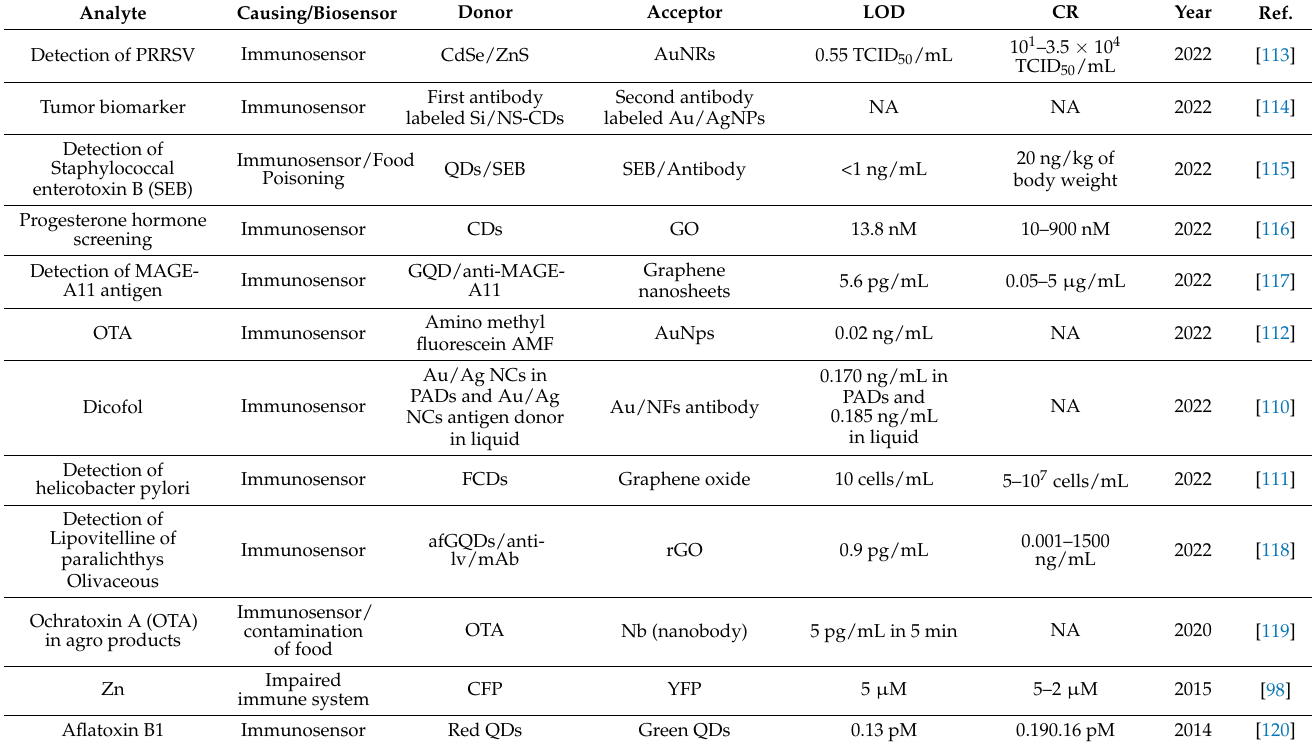
Table 1. FRET-based immunosensors showing donor, acceptor, LOD, CR, and year-wise advancement in